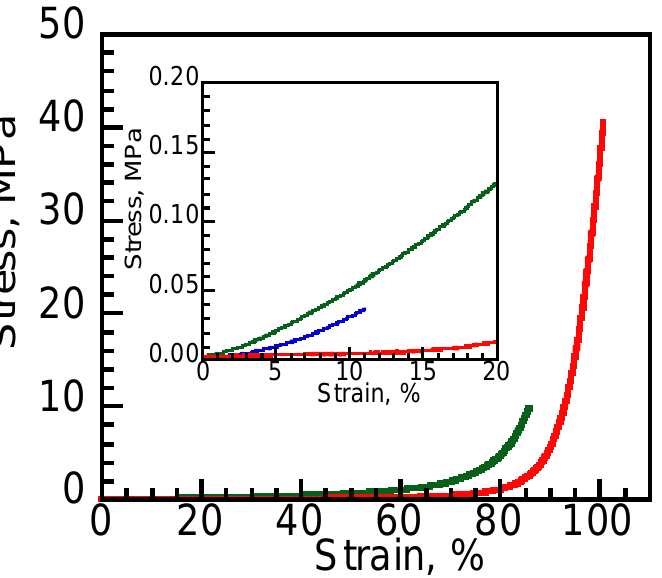
Figure 4. Compressive stress–strain curves of DNIG-1 (red line) and single network ion gel of silica (blue line) and PMMA (green line).